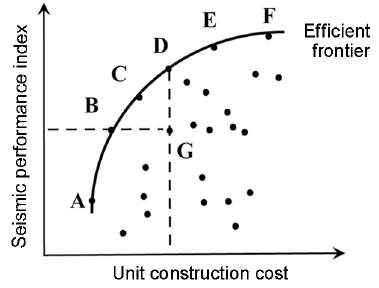
Fig. 2. Efficient frontier of school building planning